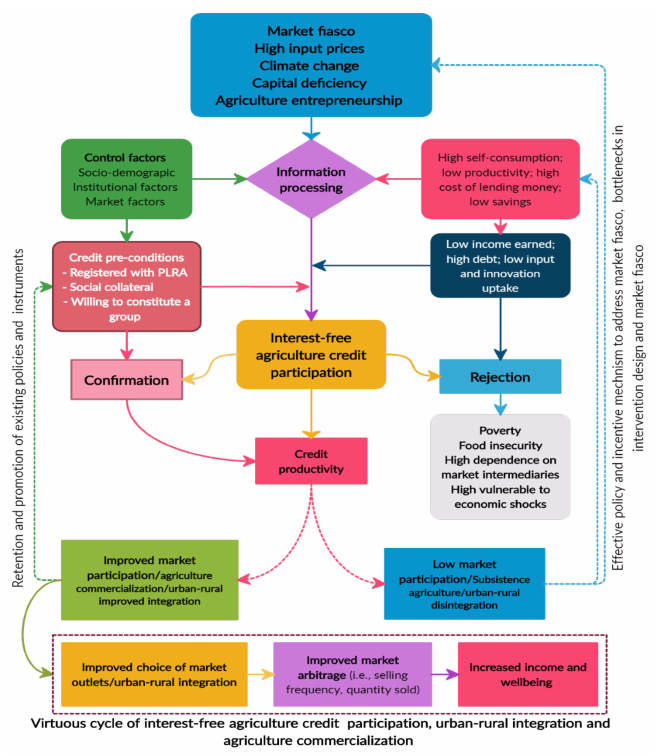
Figure 1. Interest-free agriculture credit participation, urban-rural integration and agriculture com-